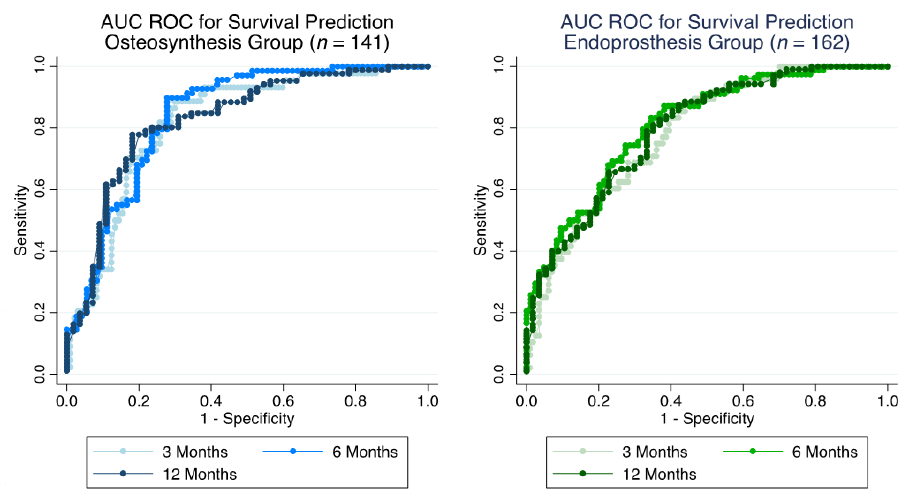
Figure 3. Accuracy of survival prediction for patients treated with osteosynthesis ( n = 141, ( left )) and endoprostheses ( n = 162, ( right )) for bone metastases of the appendicular skeleton at 3, 6 and 12 months with receiver operator characteristic area under the curve (ROC AUC), based on the 2013-SPRING model.